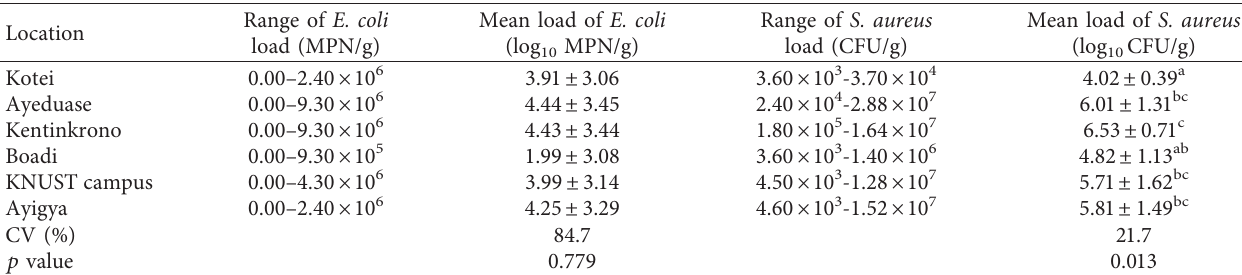
Table 2: Mean loads of E. coli and S. aureus in chevon khebab sold on the KNUST campus and its environs.